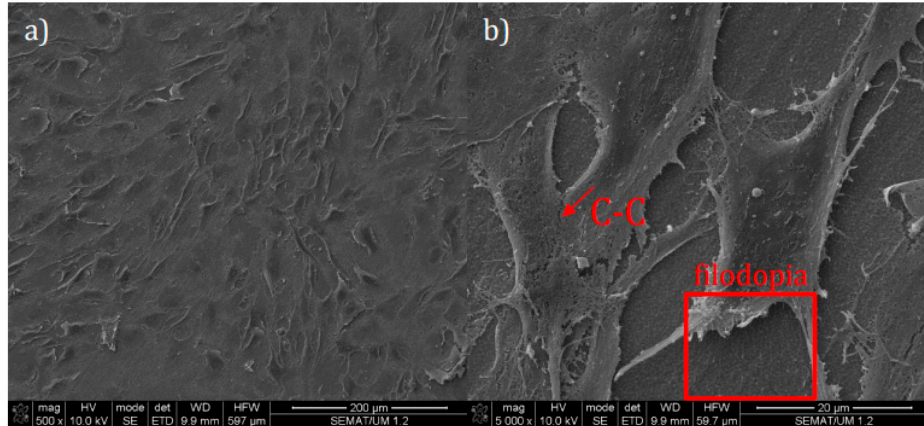
Figure 6. SEM images of the as-sintered (AS) and flat surface, indicating the ( a ) general and ( b ) detailed view of cells spreading [72]. Reprinted from [72]. Copyright from Elsevier 2020.